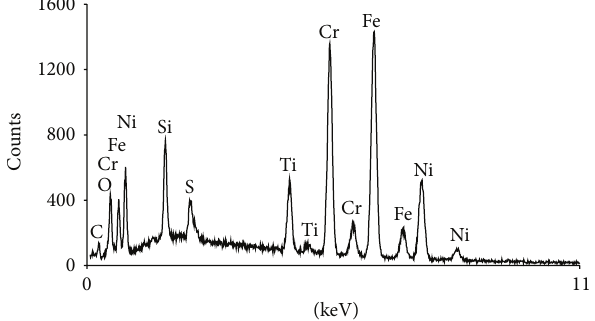
Figure 2: EDS analysis of TiO 2 coating on Magnum AN alloy.